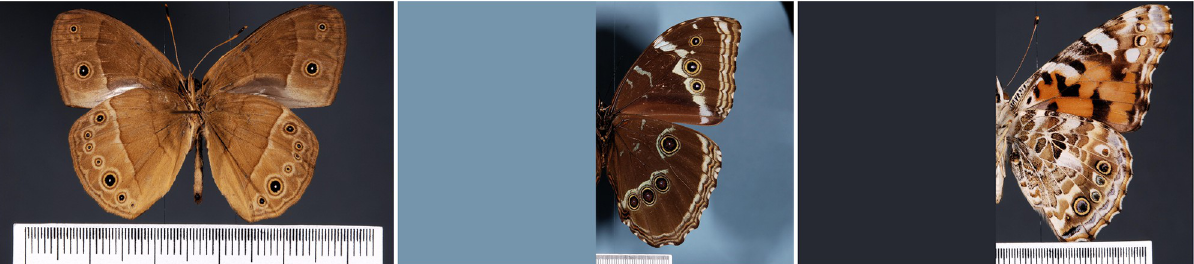
Fig 4. Examples of images from dataset1. Image of a complete butterfly and two butterfly images with left wing erased.